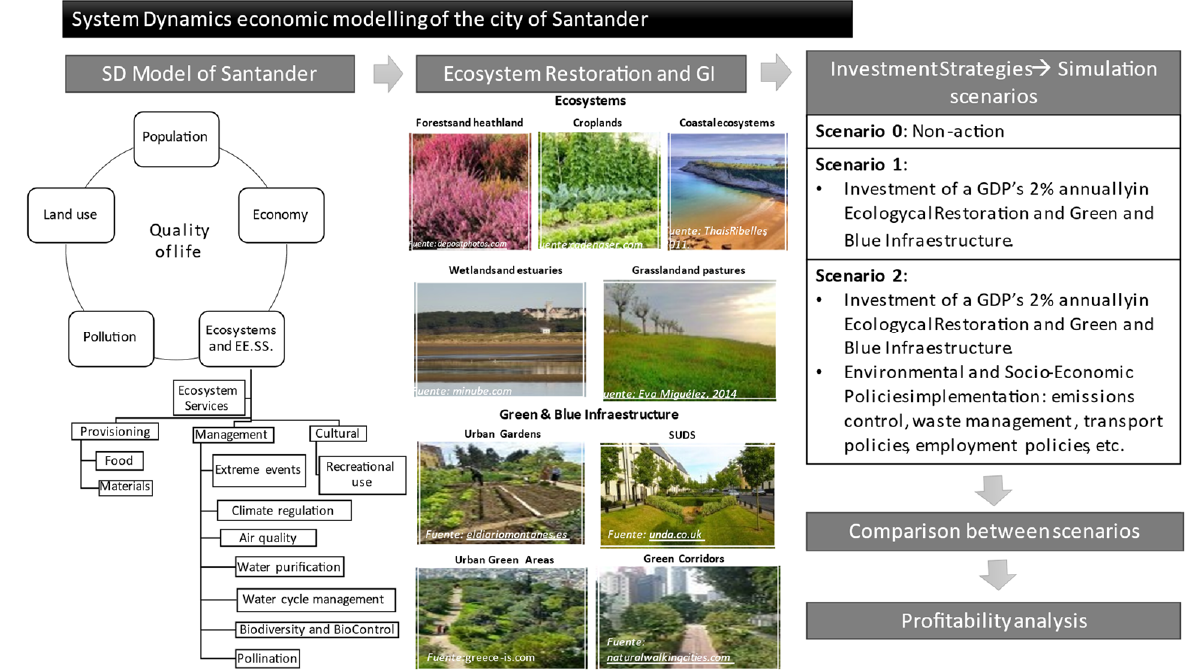
Figure 2. Schematic diagram of the steps in the methodology followed in this study. It illustrates the main components of the SD model of the city of Santander and emphasizes the principal ecosystems and GI elements present in the study area to consider in the modelling process. It also states the different scenarios simulated representative of the investment strategies considered, and the follow- ing comparison and analysis of the profitability of the investment and policies proposed (own elab- oration).